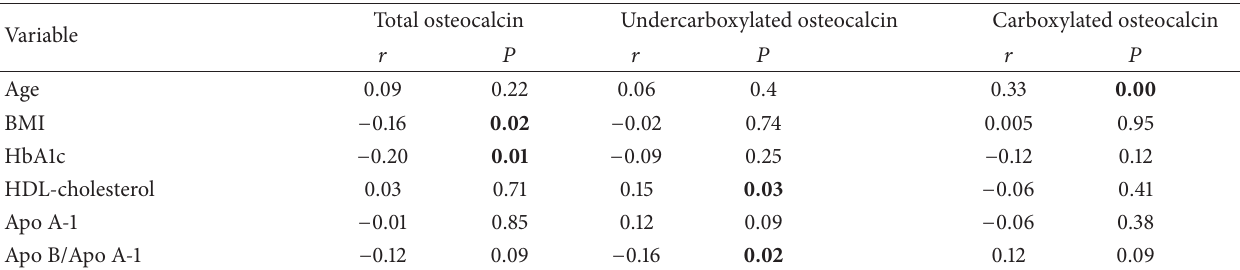
Table 2: Analysis of the overall correlation between the biochemical variables and the total and undercarboxylated osteocalcin.